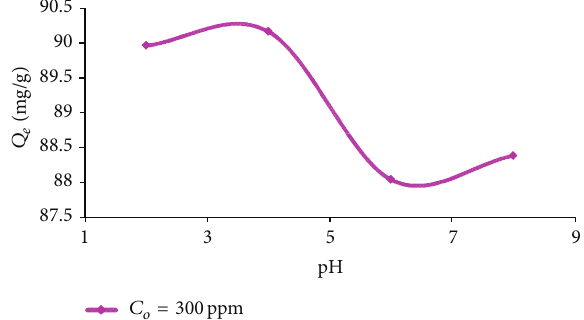
Figure 4: The effect of pH on methylene blue adsorption by